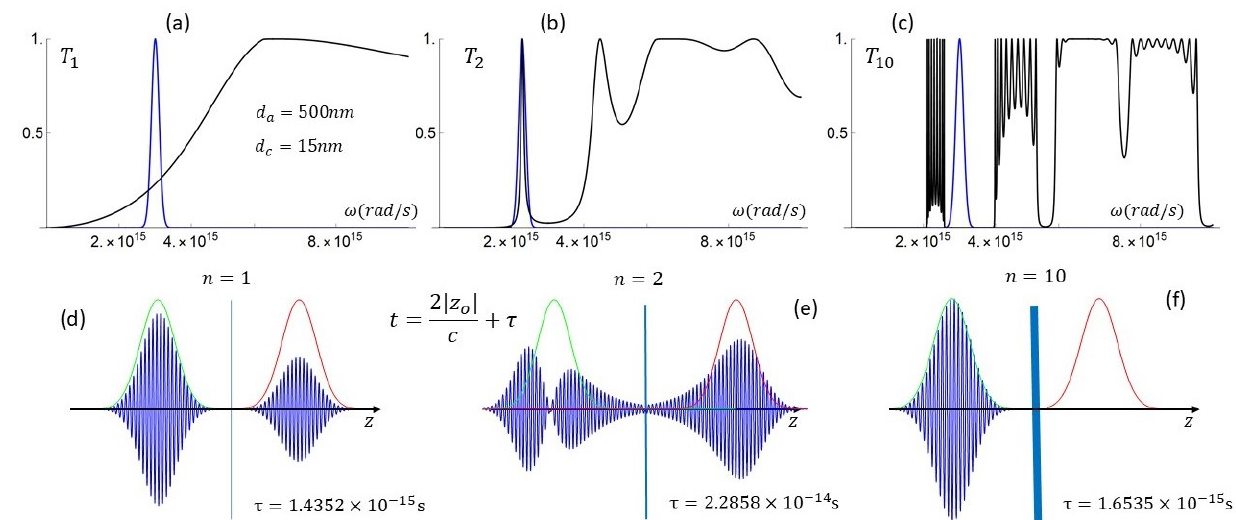
Figure 20. ( a – f ) Space time evolution of a Gaussian wave packet through metallic superlattices with n = 1, 2, and 10, in the left, middle, and right, respectively. In the upper panels we show both the transmission coefficients and the Gaussian wave packets at the frequencies at which they were defined at z o and t = 0. In the lower panel, we have the reflected and transmitted wave packets at t = 2 | z o | / c + τ , where τ the tunneling time of the wave packet components of frequency ω o . The green and red Gaussian curves, define the positions at which the reflected and transmitted packets should be if τ is truly the tunneling and reflecting time. Notice that the reshaping of the transmitted and reflected packets are strongly determined by the transmission coefficients in the frequencies domain where the packets are defined, at a resonance in the middle and at a gap in the